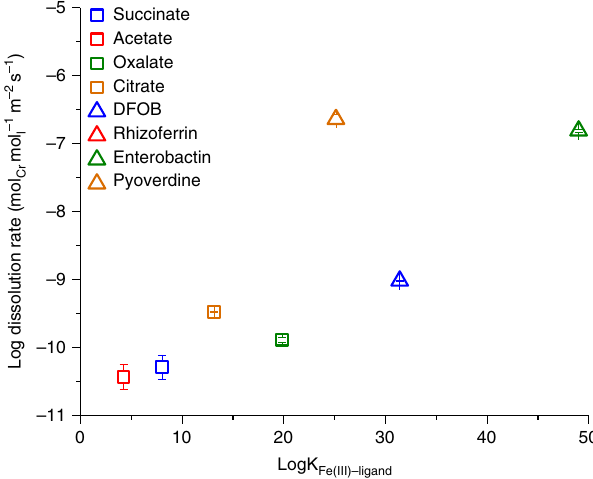
Fig. 4 Cr dissolution rate vs metal – ligand stability constants. Initial dissolution rates of 0.2 g l − 1 of Cr(OH) 3 (mol Cr mol ligand − 1 m − 2 s − 1 ) at pH 7 and ionic strength of 0.1 M as a function of the stability constant of the corresponding Fe(III) – ligand complexes. Stability constants are for Fe (III) – organic acid complexes 44 predicted to be the most thermodynamically stable under these conditions using MINTEQ 43 . Fe(III) – siderophore stability constants are for the Fe(III) – siderophore complex with a completely unprotonated ligand (see ref. 45 and references therein). Fe(III) – ligand stability constants are presented for consistency due to the similarity in ionic potential between Fe(III) and Cr(III), because Cr(III) – ligand stability constants are not available for all